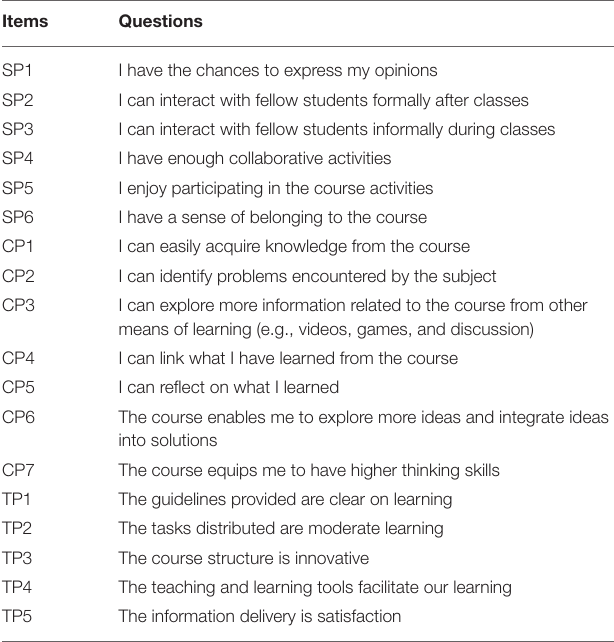
TABLE A | The questions used to measure the CoI in the